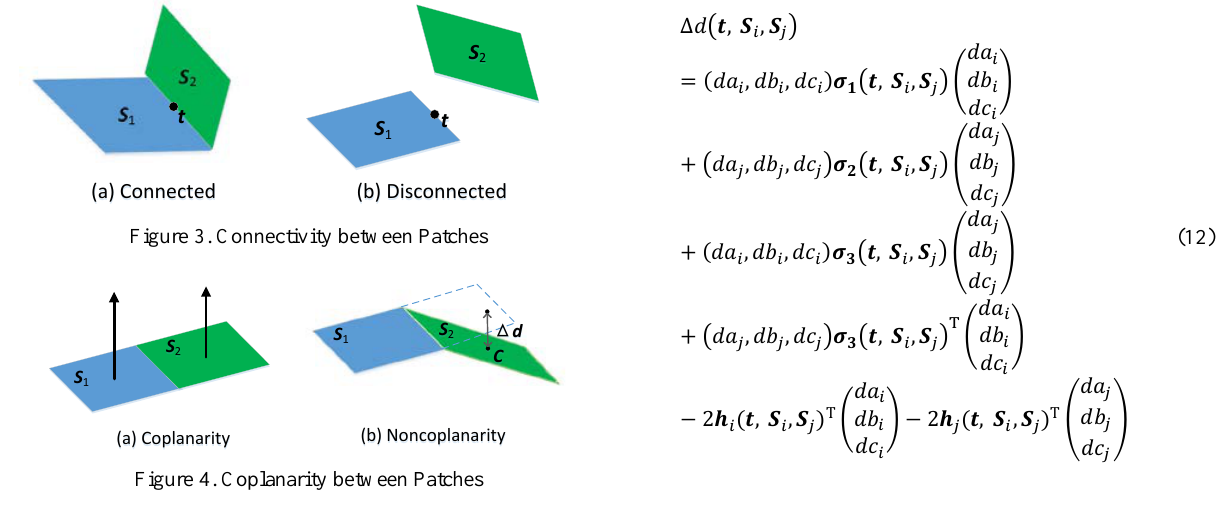
Figure 4. Coplanarity between